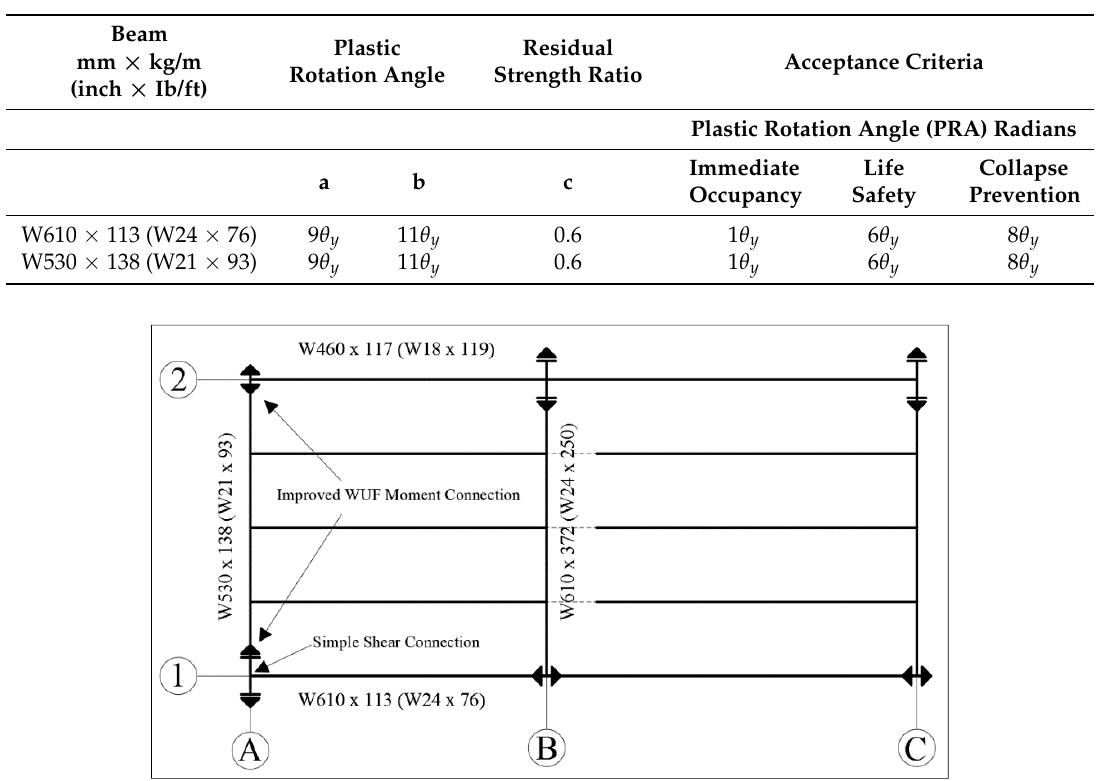
Table 2. Acceptance citeria and plastic hinge parameters for beams framing into corner column A1.